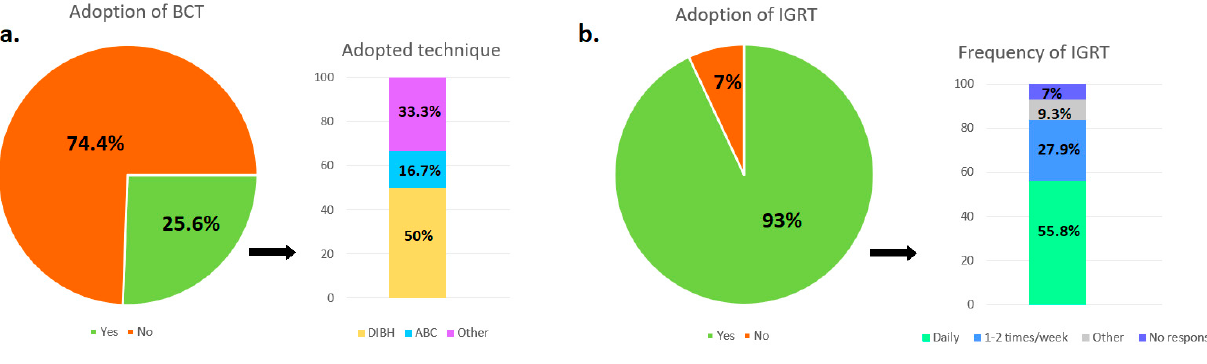
Figure 2. Adoption of breathing control techniques (BCTs) ( a ) and type of technique adopted (DIBH = deep inspiration breath hold; ABC = active breathing control), and adoption of image-guided radiotherapy (IGRT) ( b ) and frequency of its use across different centers.